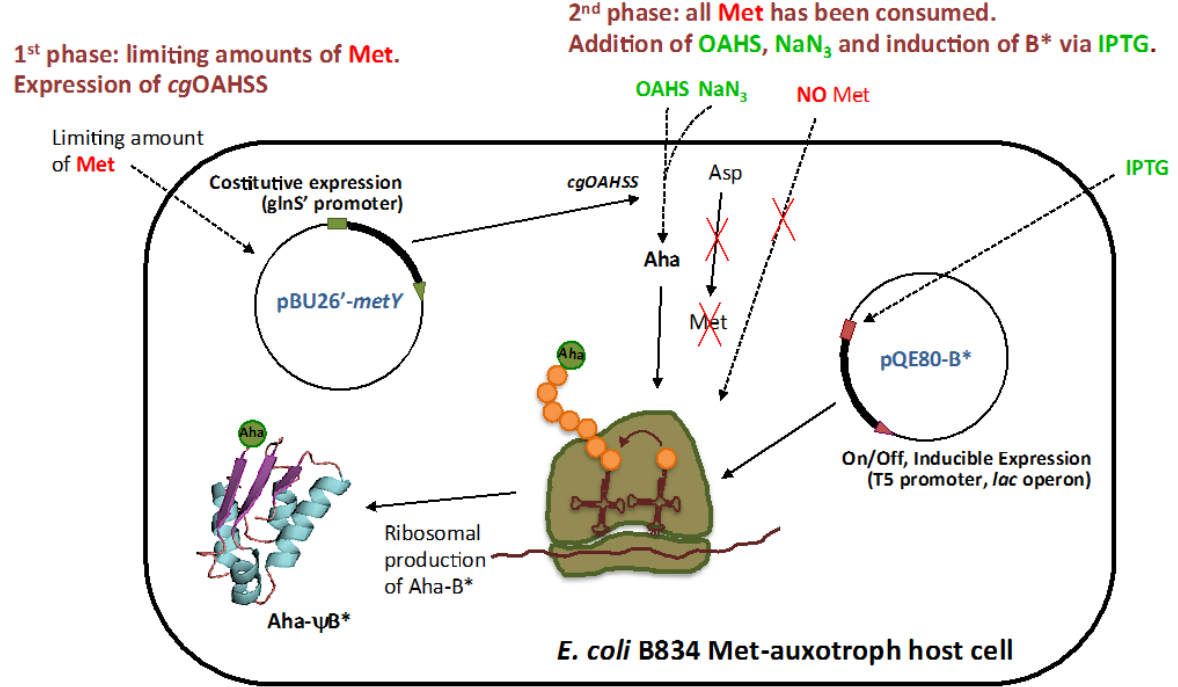
3. General method for intracellular L -azidohomoalanine production